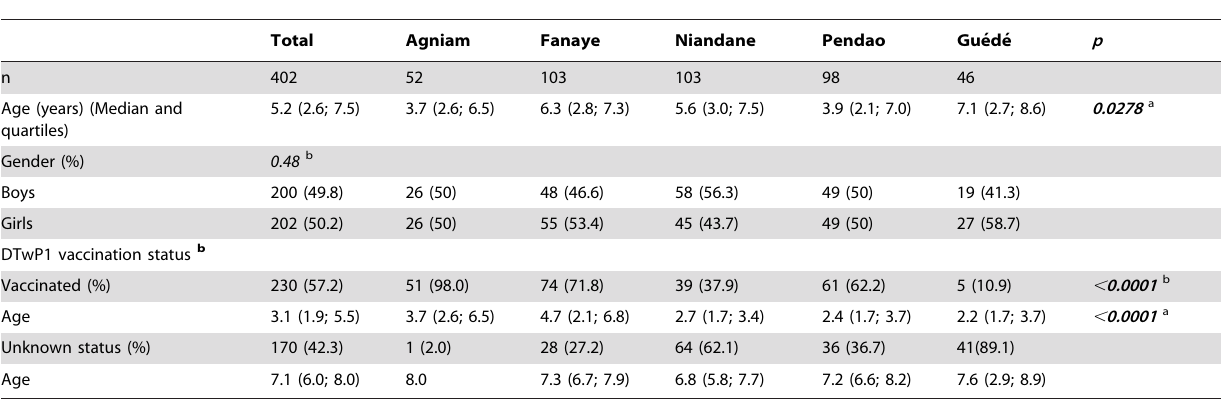
Table 1. Description of the cohort at the beginning of the survey (T1).